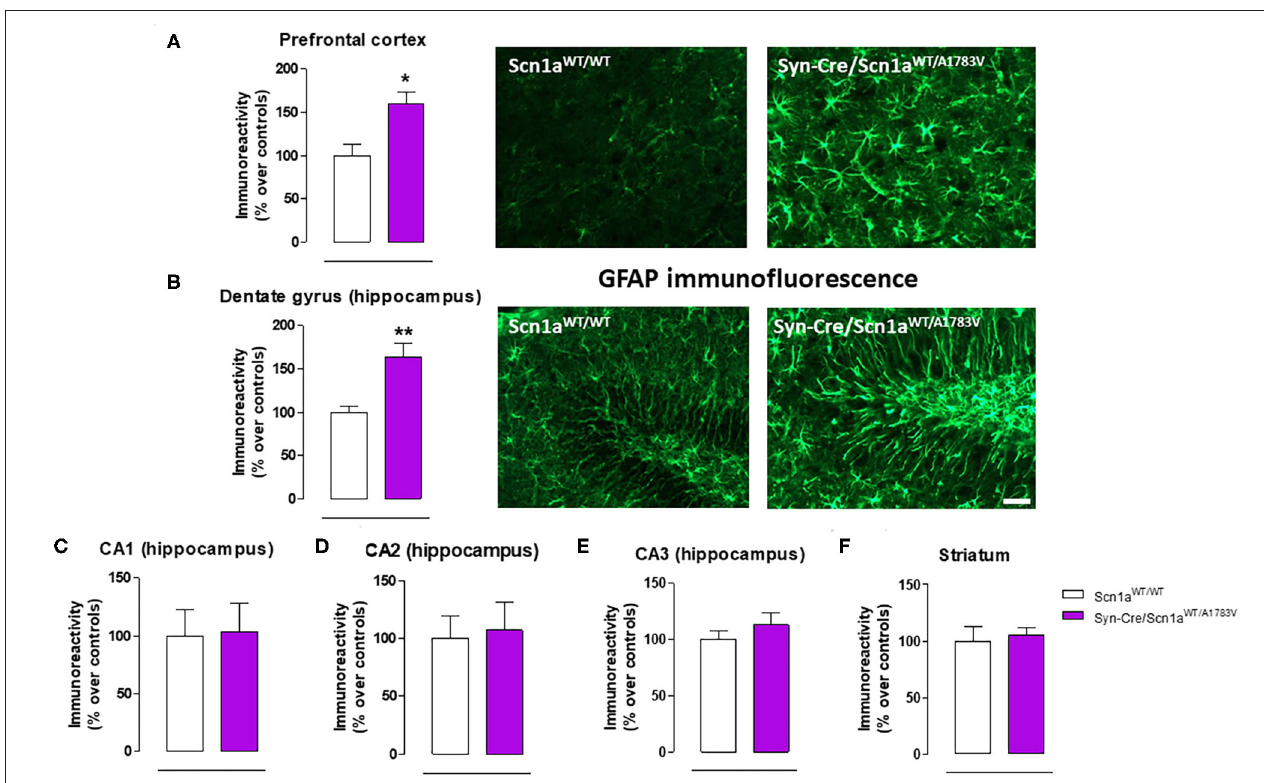
FIGURE 6 | Immunoreactivity for the astroglial marker GFAP measured by immunofluorescence in different CNS structures, including representative immunofluorescence images in the prefrontal cortex and the hippocampal dentate gyrus of Syn-Cre/Scn1a WT / A1783V mice compared with Scn1a WT / W animals at PND25. Values are % over controls and correspond to means ± SEM of five to six animals per group. Data were assessed by the Student’s t -test (* p < 0.05, ** p < 0.01 vs. the control group). Scale bar = 100 µ m.